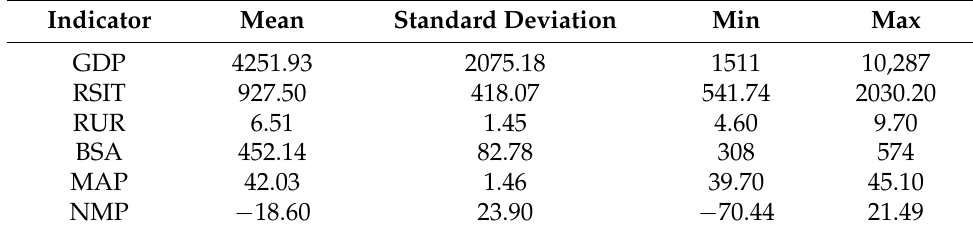
Table 2. Summary statistics for the indicators included in the SERes Index.